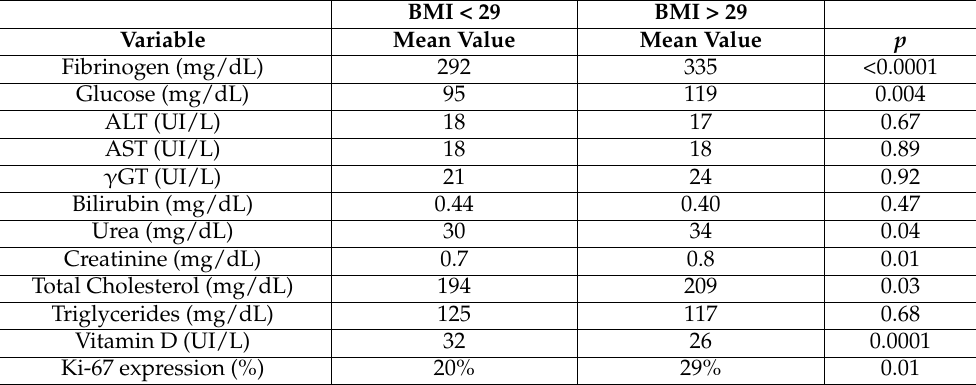
Table 3. Biochemical parameters of postmenopausal BC patients stratified according to BMI prior to AI treatment